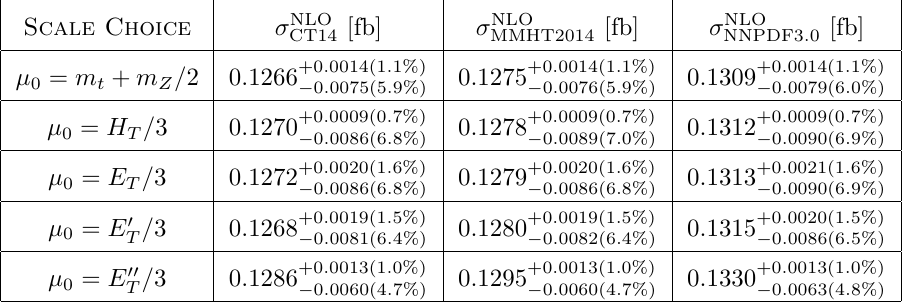
Table 4 . NLO cross sections for the pp e + (cid:23) e (cid:22) (cid:0) (cid:22) (cid:23) (cid:22) b (cid:22) b (cid:23) (cid:28) (cid:22) (cid:23) (cid:28) + X process at the LHC run II with ! p s = 13 TeV. Results for three di(cid:11)erent PDF sets are presented. Also included are theoretical errors as obtained from the scale